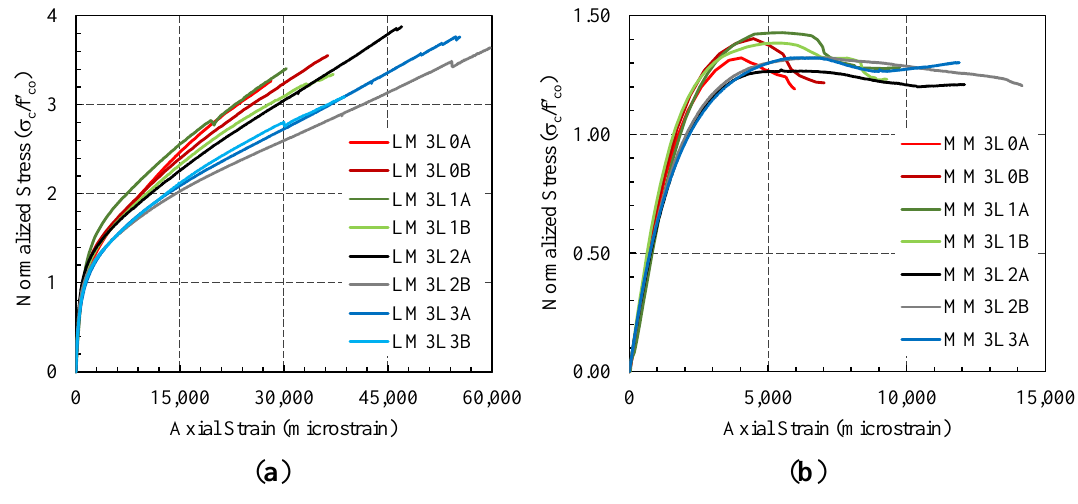
Figure 3. Stress-strain behavior of carbon fiber-reinforced polymer (CFRP)-confined specimens under different loading rates. ( a ) Low-strength concrete. ( b ) Medium-strength